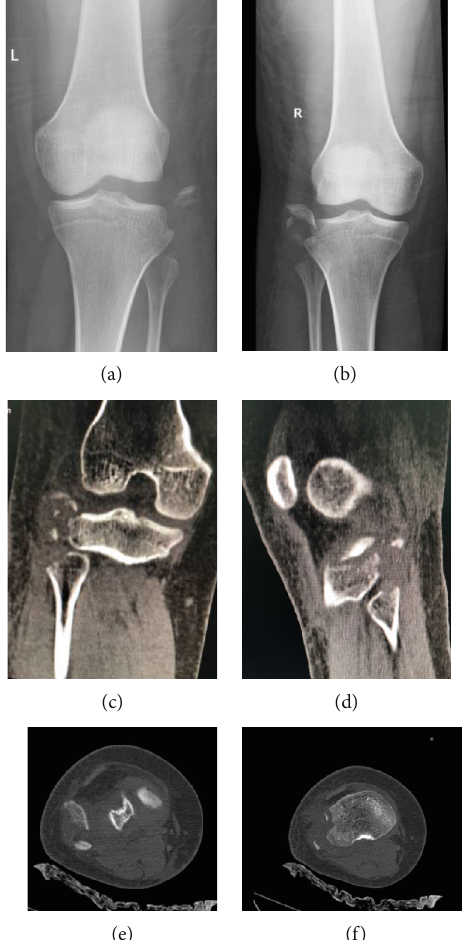
Figure 1: (a, b) Anteroposterior radiography of the knees showing a Segond fracture associated with an arcuate fracture. (c, d) CT of right knee in coronal view and left knee in sagittal view showing avulsion of the fi bular head associated with avulsion fracture of the left with small fragments. (e, f) Right knee axial CT